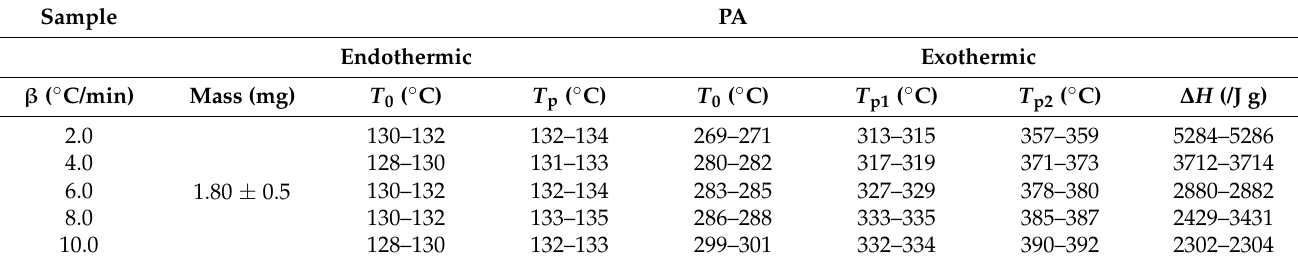
Table 2. Calorimetric data from dynamic scanning experiments of